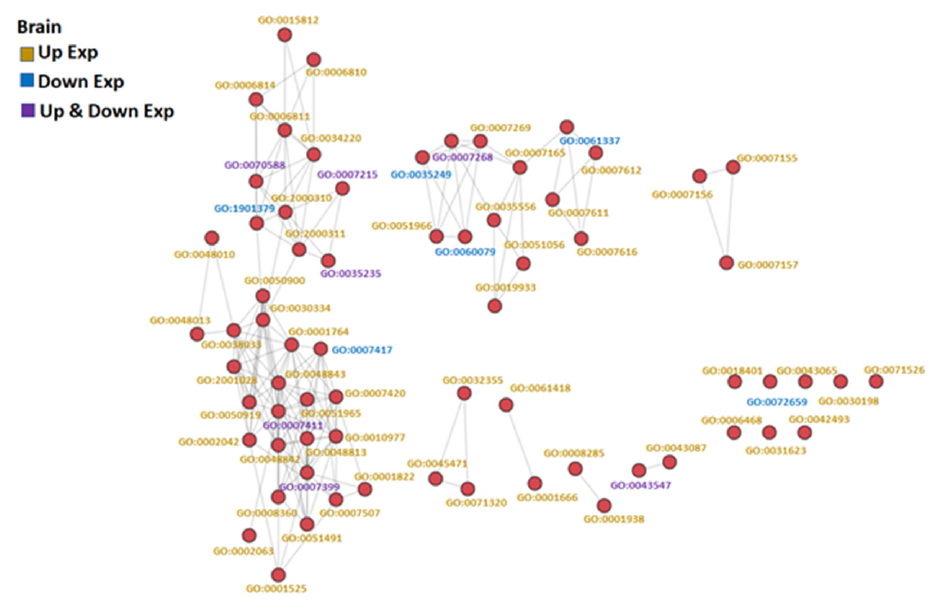
Figure 3. GO similarity network analysis of common carp brain under hypoxic conditions: The three similarity scores and three association scores were computed for each GO term pair, and a bubble network map was created.